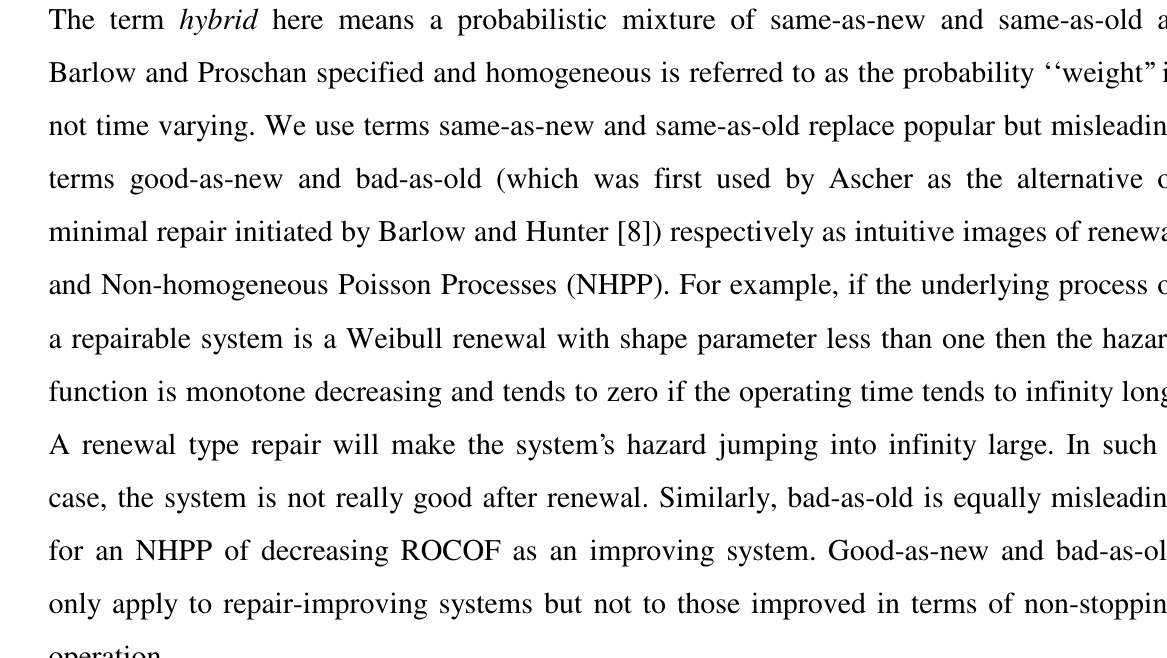
Table 1: Pham-Wang’s model